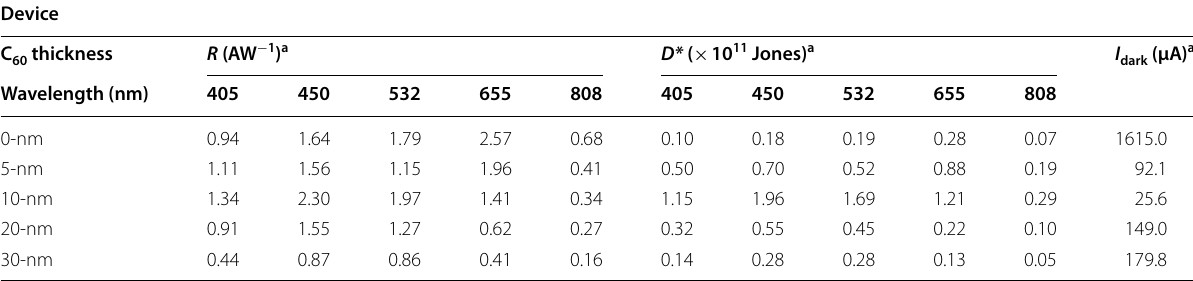
a All results were obtained at a reverse bias voltage of